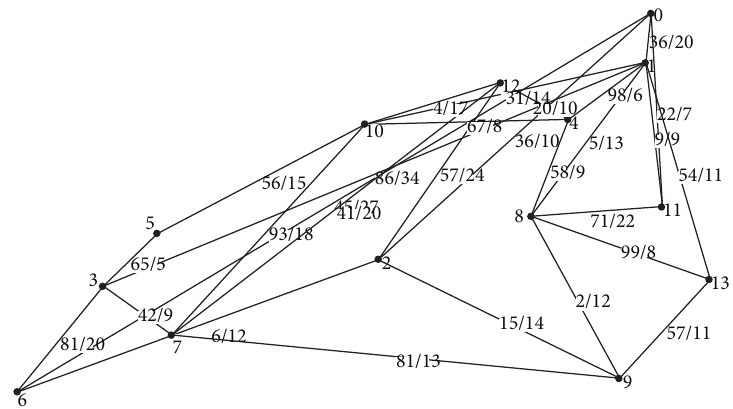
Figure 3: A randomly generated network with 14 nodes and average degree